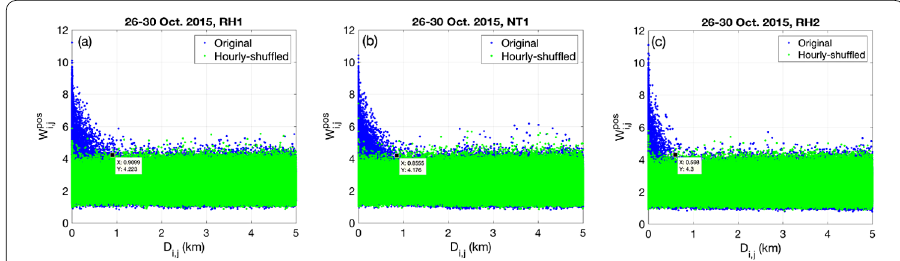
Figure 3 Thresholds for constructing correlation networks. ( a ) W pos VS D i , j . The results after hourly shuffling i , j are shown by green points. Here, for each pair of nodes i and j , we randomly shuffle the two time series independently with hourly intervals. To make the comparison clearer, the x -axis is limited from 0 to 5 km. The thresholds for constructing network is thus W min = 4.2 and D max = 0.91 (km). ( b ), ( c ) The same as ( a ) but for NT1 and RH2. The corresponding thresholds are W min = 4.2, D max = 0.86 (km) for NT1, and W min = 4.3, D max = 0.60 (km) for RH2. The data is during 26–30 Oct. 2015, N = 4530, L = 900, and τ max =